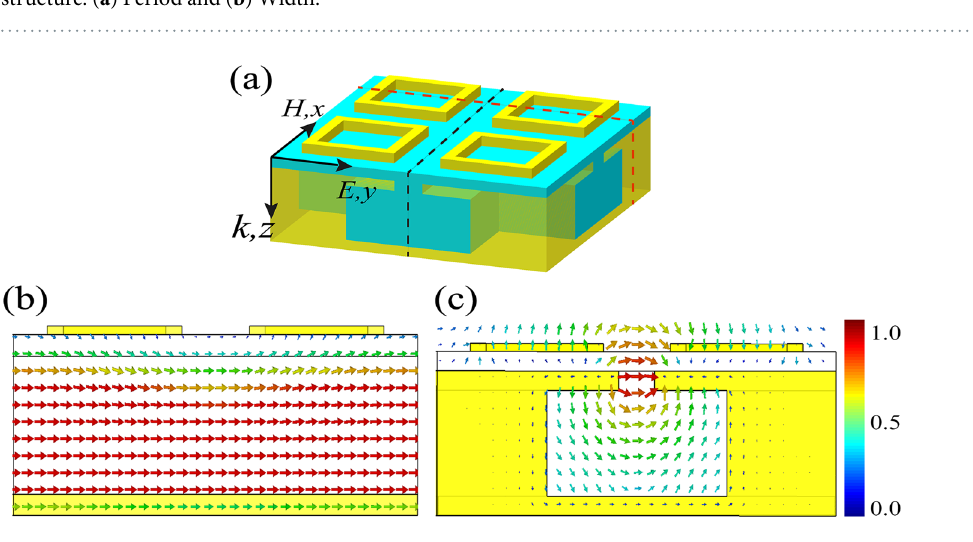
Figure 5. Magnetic field, electric field and effective capacitance model of the designed absorber at 10.6 μ m. ( a ) The geometrical model of the absorber. The black dotted line shows the position of cross section view for ( b ) Magnetic field distribution. The red dotted line shows the position of cross section view for ( c ) Electric field